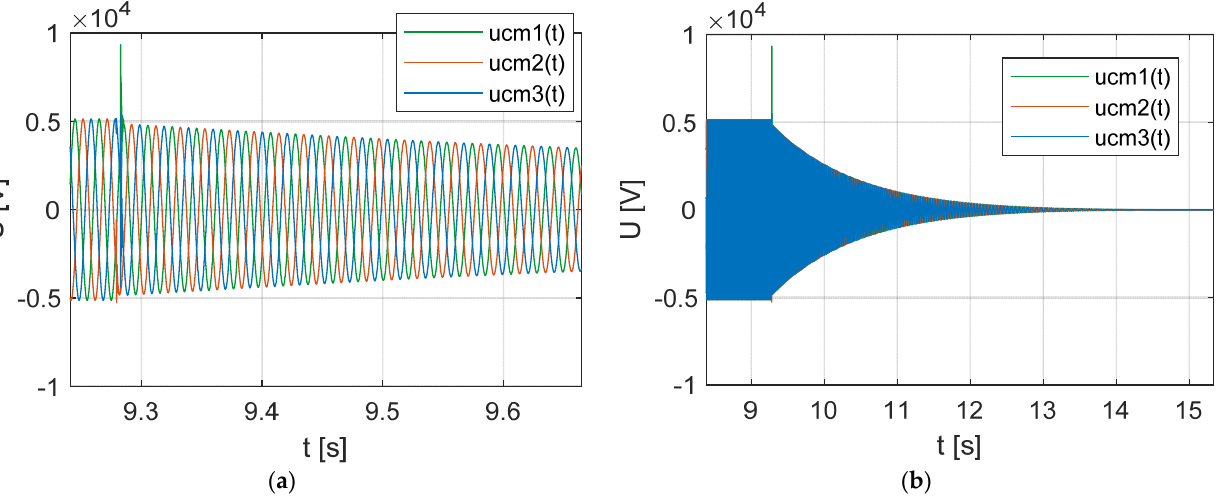
(𝑡) ; ( b ) en- ( t ) ; ( b ) entire (𝑡) ; ( b ) en- (cid:3261) (cid:3261) L